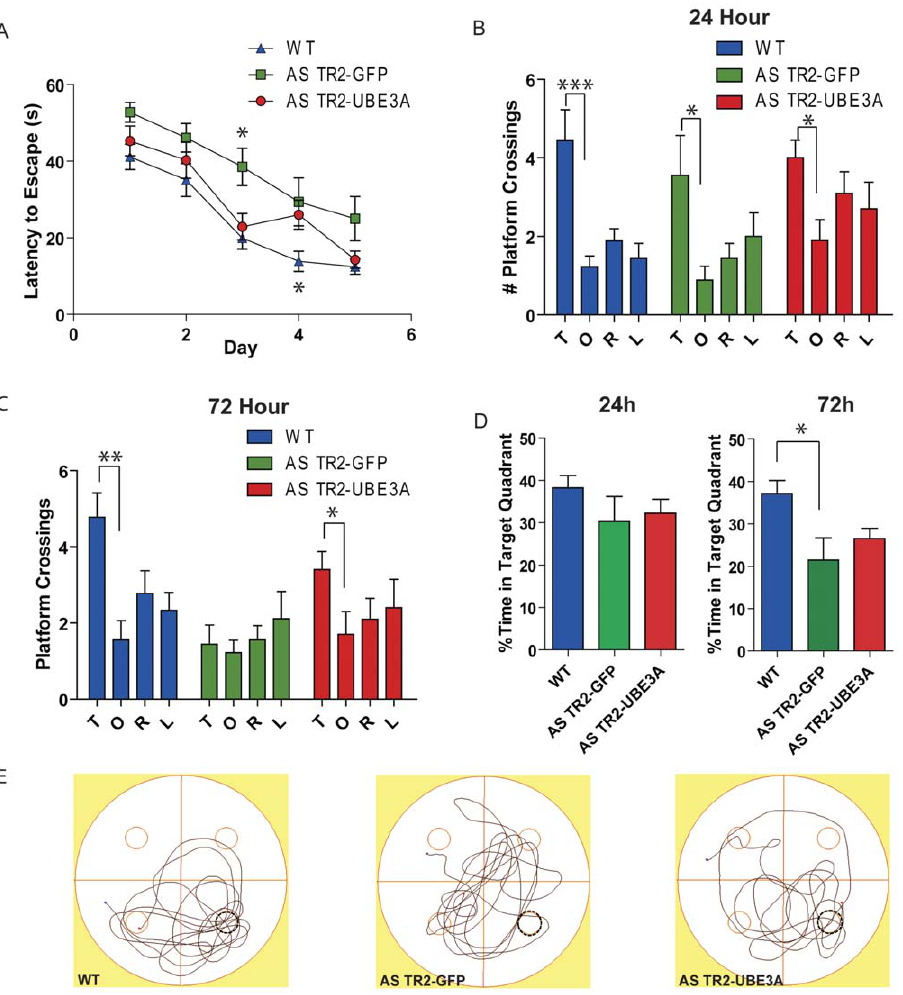
Figure 5. AS TR2-UBE3A mice had significant improvements in the Morris water maze. (A) Escape latency to reach the platform during 5 days of training in Morris water maze. The only significant differences seen were an increase in latency for the AS TR2-GFP mice on day 3 and a decrease in latency for wildtype mice on day 4 compared to the other two groups (2-way ANOVA Bonferroni: Interaction [F(8,100)=1.01, P . 0.05 ]; Treatment [F(2,100)=5.30, P , 0.05 ]; Time [F(4,100)=53.49, P , 0.0001 ]; Matching [F(25,100)=5.37, P , 0.0001 ]). The target platform is indicated by the black circles. (B) Quantification of the number of platform crossings in the target (T), opposite (O), right (R), and left (L) quadrants during the probe trial of the Morris water maze 24 hours after training indicate no significant differences among any of the groups in comparing target platform crossings to opposite platform crossings (ANOVA Tukey WT: [F(3,35)=9.546, P , 0.0005 ]; AS TR2-GFP: [F(3,35)=3.186, P , 0.01 ]; AS TR2-UBE3A: [F(3,39)=2.814, P , 0.05 ]). All three groups learned the platform location based on a spatial bias as indicated by the time spent in the target quadrants (Fig. 5D 24 h ANOVA Tukey [F(2,26)=1.027, P . 0.05 ]) (C) A probe test 72 hours after training indicate that the WT and AS TR2-UBE3A groups had significantly more target platform crossings compared to the number of opposite platform crossings (ANOVA Tukey WT: [F(3,35)=6.086, P , 0.005 ]; AS TR2-GFP: [F(3,35)=0.5650, P . 0.05 ]; AS TR2-UBE3A: [F(3,39)=2.679, P , 0.05 ]), but this improvement was not spatially biased as seen by the time spent in the target quadrant (Fig. 5D 72 h ANOVA Tukey [F(2,25)=5.067, P , 0.02 ]). Results shown represent the mean with standard